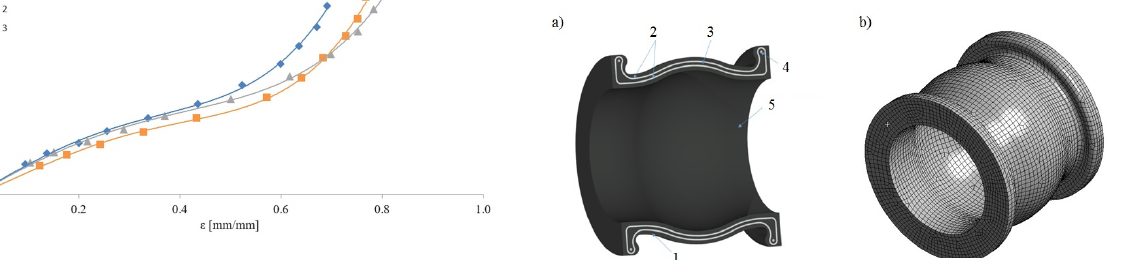
Figure 9: Biaxial tension of the NBR 65 ∘ Sha ted as a biaxial characteristic presented in Fig. 9. The me- chanical strength of the rubber under biaxial deflection is prominently lower than uniaxial because rupturing took place at twice lower stress and strain.